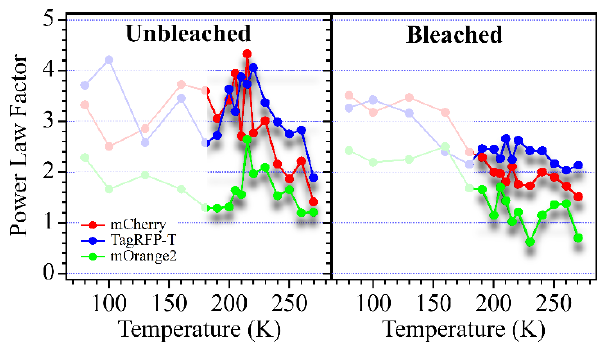
Figure 3. Power law factors from fits to THz absorption frequency dependence for unbleached ( left ) and bleached ( right ) RFP samples: mCherry (red), TagRFP-T (blue), and mOrange2 (green) as a function of temperature. The high temperature region above dynamical transition has been emphasized.